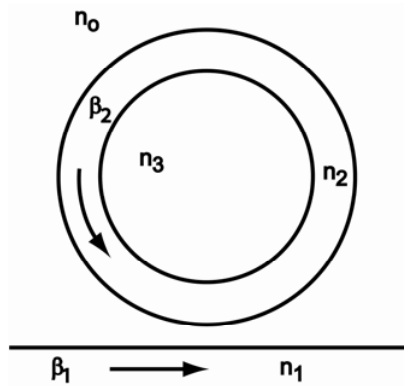
Figure 10. Schematic diagram of the ring resonator coupled to a